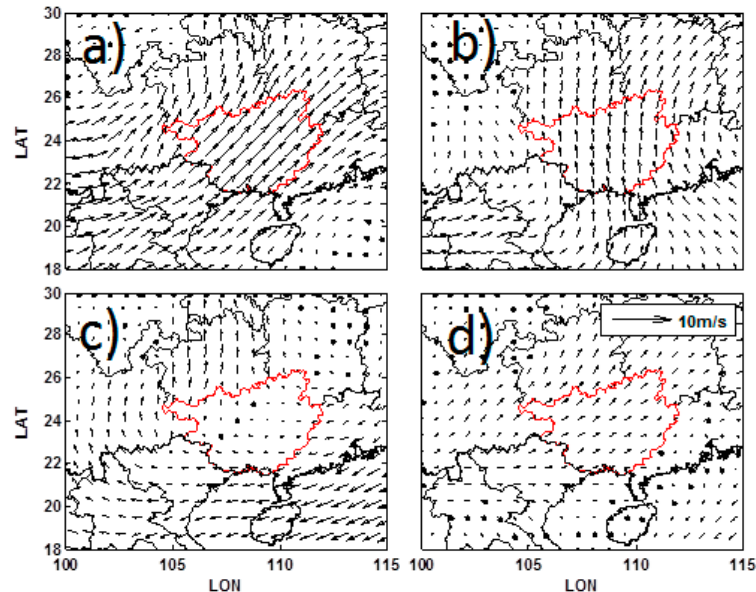
Figure 13. Monthly winds at 800 hPa in 2014 based on ECMWF. ( a ) April; ( b ) July; ( c ) October; ( d ) January.